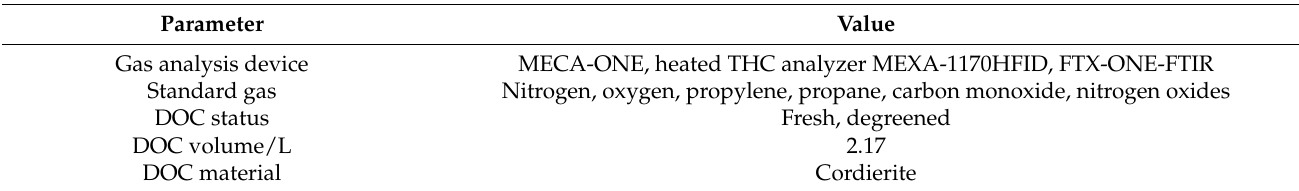
Figure 1. Schematic diagram for SGBT. 1 in ( a ) Testing and monitoring equipment 2 in ( a ) Standard gas ( b ) SGBT sampling. Table 1. Test equipment for SGBT.